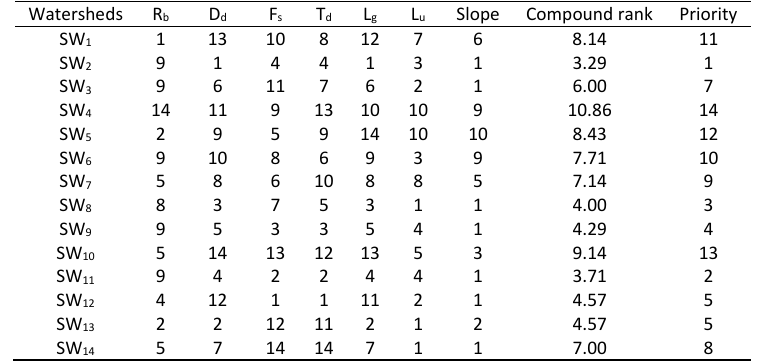
Table 5: Subwatershed ranks based on geomorphometric parameters with direct effect to erosion